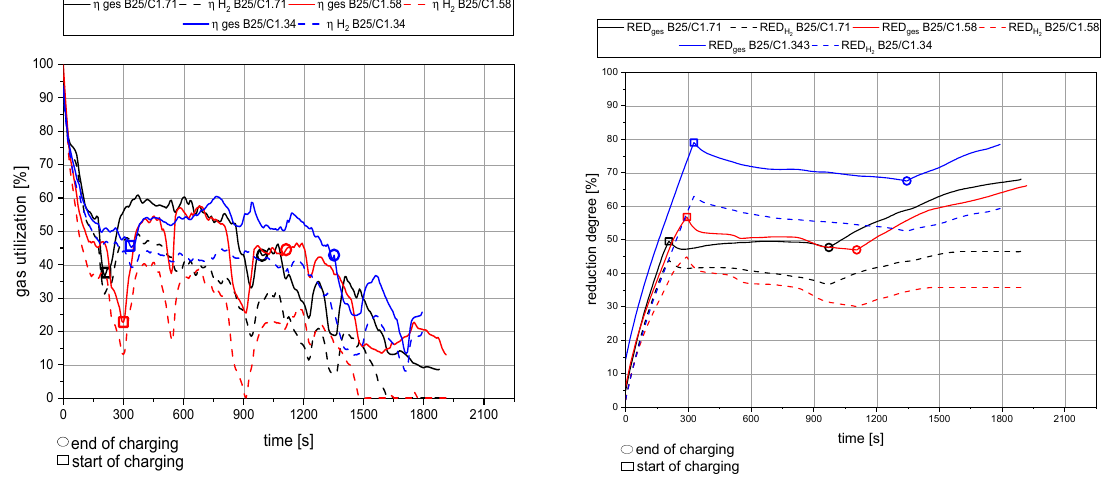
Figure 13. Gas utilization and reduction degree at 50 g batch and 50 g charged mass at 20 rounds per minute of the dosing unit.